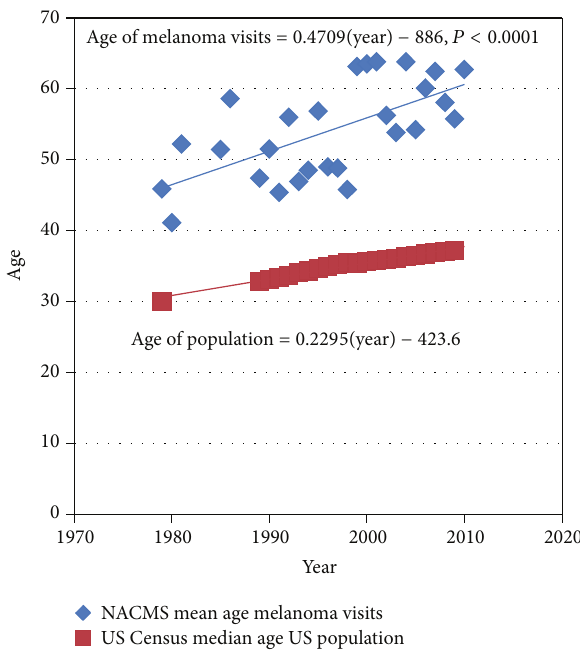
Figure2:MeanageofmelanomavisitsfromtheUSNationalAmbu- latory Medical Care Survey (NAMCS) from 1979 to 2010 compared to median age of US population.